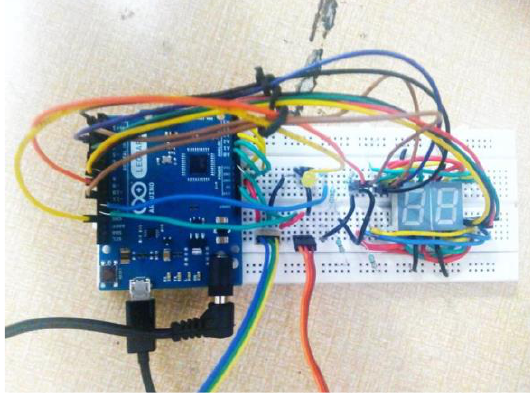
Fig. 13. Breadboard implementation of the final